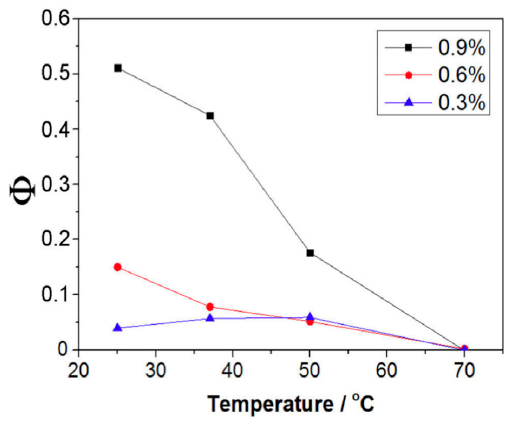
Figure 3. Self-assembled portion of 1 in solutions determined by 1 H-NMR.